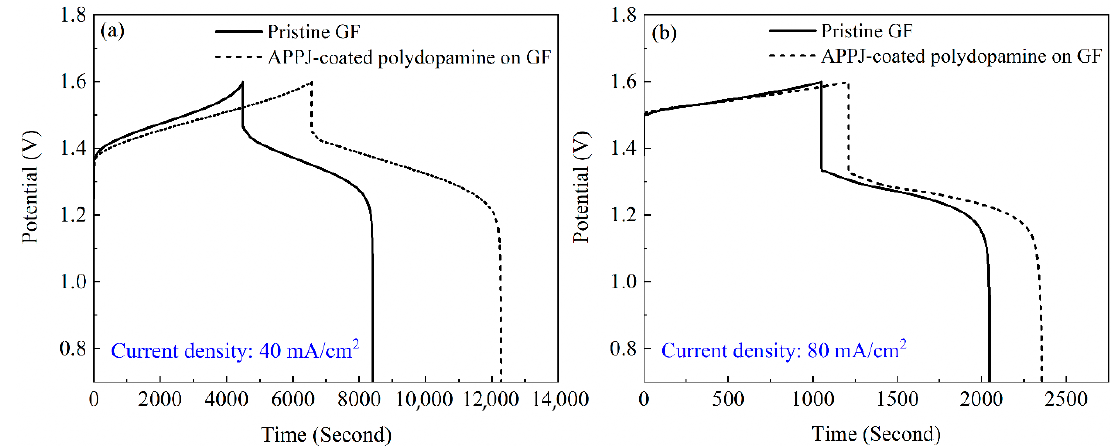
Figure 8. Charge–discharge curves of VRFB single cell using pristine GF and APPJ-coated polydopamine on GF as electrodes at a current density of ( a ) 40 mA/cm 2 and ( b ) 80 mA/cm 2 .